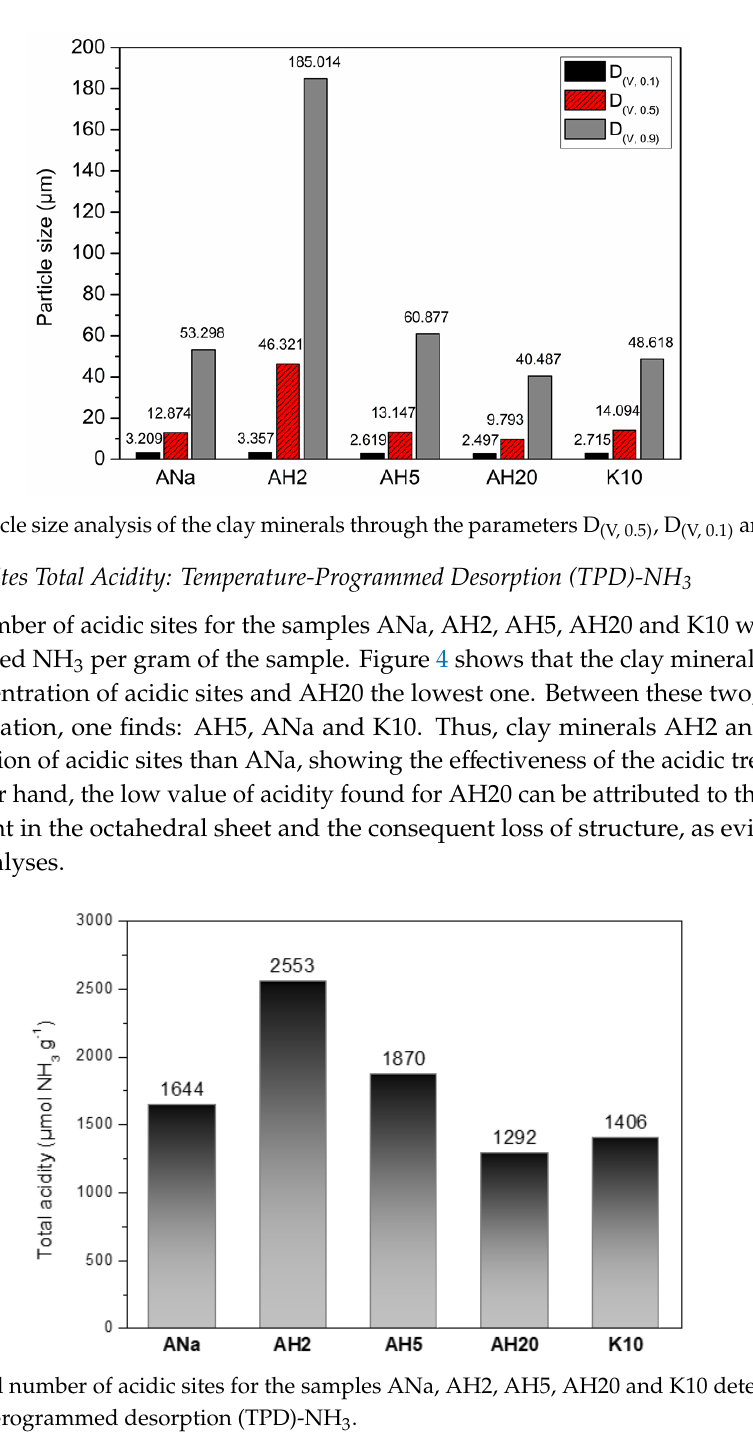
Figure 4. Total number of acidic sites for the samples ANa, AH2, AH5, AH20 and K10 determined by temperature-programmed desorption (TPD)-NH3.